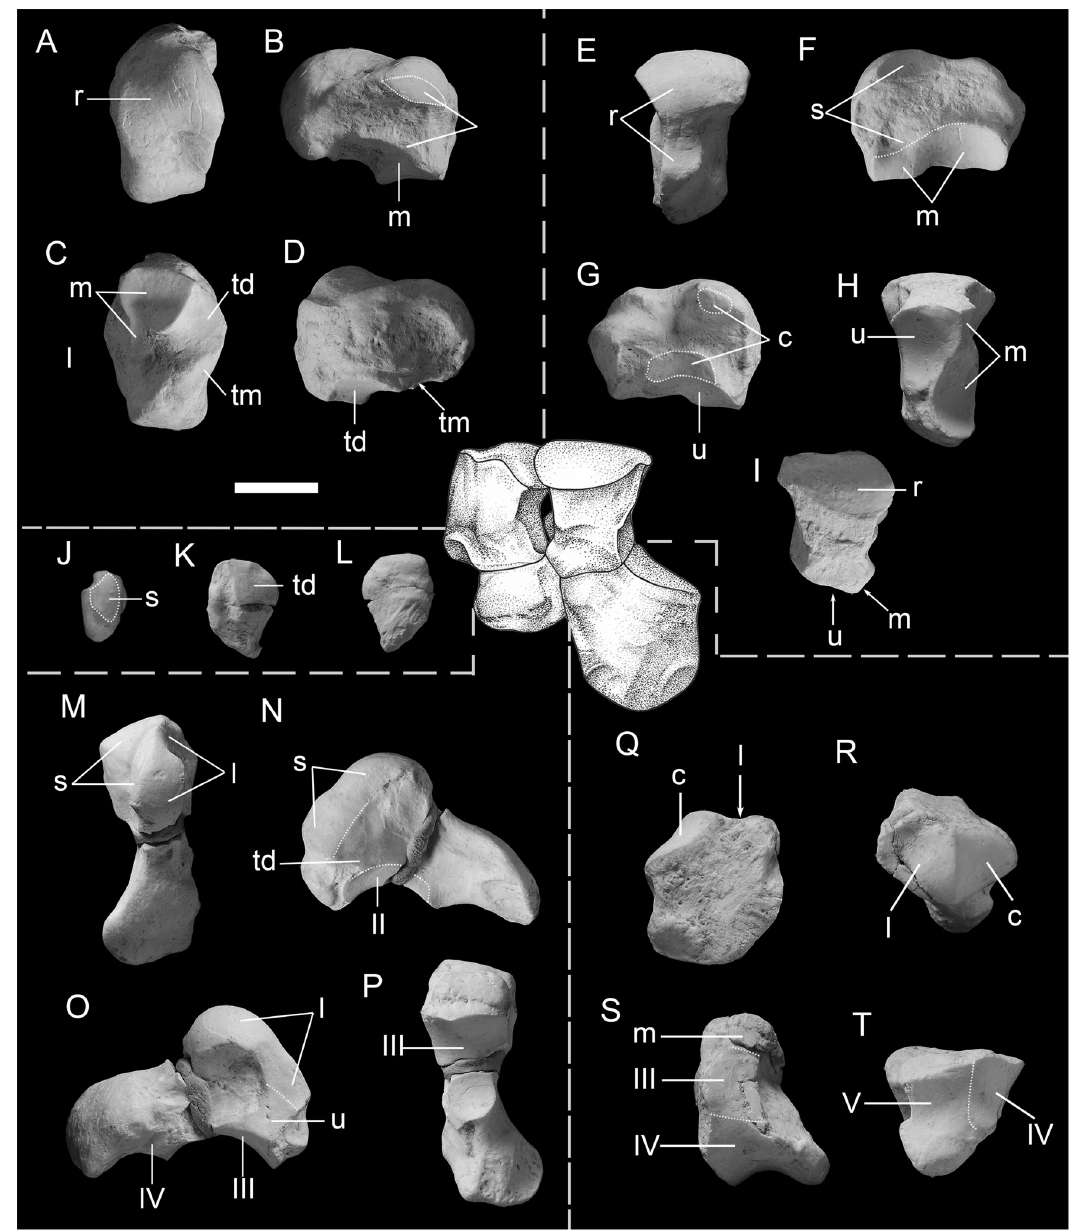
Fig 3. Carpals of the primitive deperetellid Irenolophus qii gen. et sp. nov. (IVPP V 25831). A reconstruction of articulated left carpals (reversed) in anterior view in the center. (A to D) right scaphoid in proximal (A), lateral (B), distal (C), and medial (D) views. (E to I) right lunar in proximal (E), medial (F), lateral (G), distal (H), and anterior (I) views. (J to L) right trapezium in proximal (J), anterior (K), and posterior (L) views. (M to P) right magnum in proximal (M), medial (N), lateral (O), and distal (P) views. (Q to T) right unciform in anterior (Q), proximal (R), medial (S), and distal (T) views. Abbreviations: c, cuneiform; l, lunar; m, magnum; r, radius; s, scaphoid; td, trapezoid; tm, trapezium; u, unciform; III, IV, V, third, fourth, and fifth metacarpals.